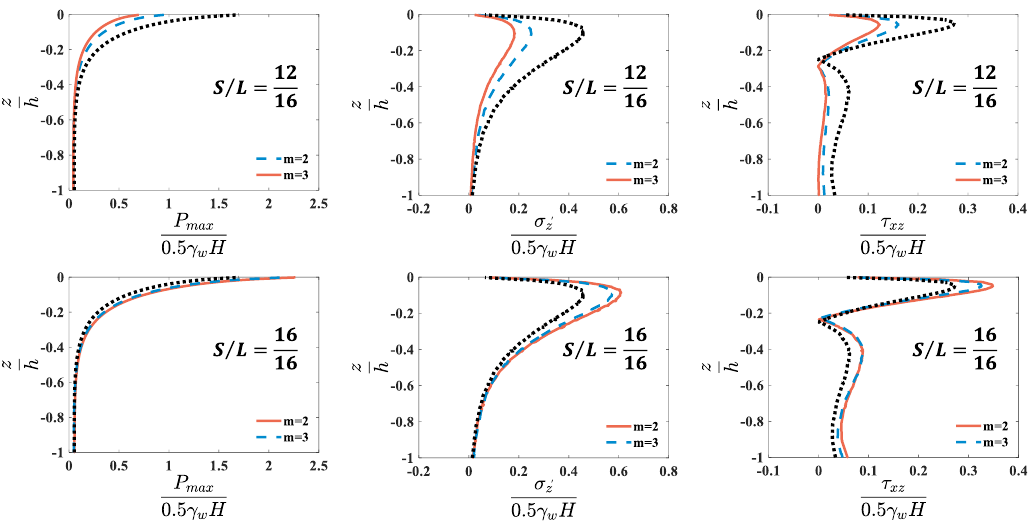
Figure 21. Vertical distributions of the maximum wave−induced pore pressure, the effective normal stress, and the shear stress below the toe of vertical breakwater for the different configurations with 𝑘𝑑 = 0.6 . The dotted line is the wave-induced stress under the rigid breakwater condition, only.